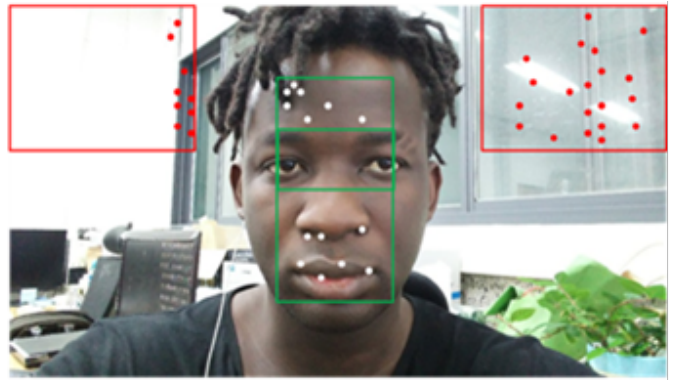
Figure 2. Location of facial and background features used in [23]. Red circles in the upper corner ROIs represent background features, and white circles inside the central ROIs represent facial